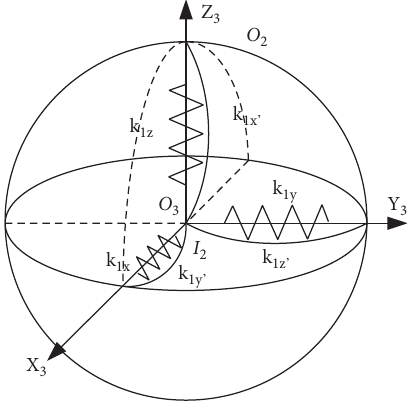
Figure 5: Spatial elastic